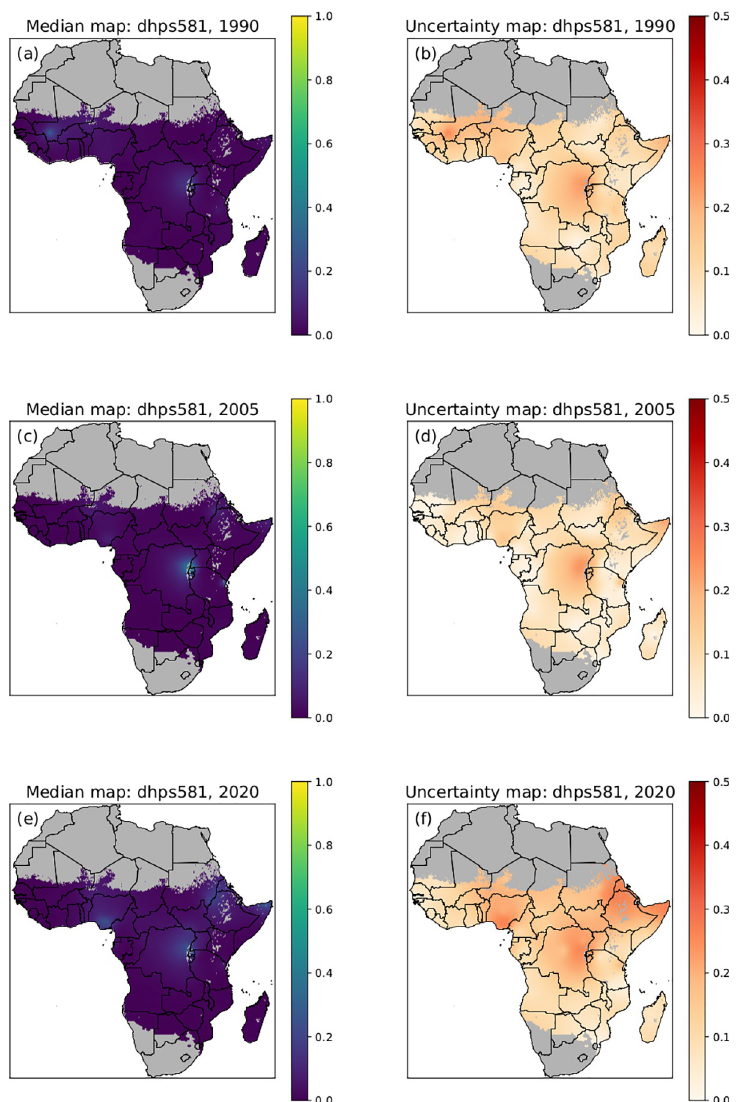
Fig 4. Posterior predictive median prevalence of pfdhps 581G. Posterior predictive median prevalence of pfdhps 581G in 1990 (a), 2005 (c) and 2020 (e). Associated standard deviations (uncertainty) for pfdhps 581G posterior predictions in 1990 (b), 2005 (d) and 2020 (f). A low standard deviation (lighter colour) indicates low uncertainty and high confidence in the model. National shapefiles were obtained from the Malaria Atlas Project (MAP;